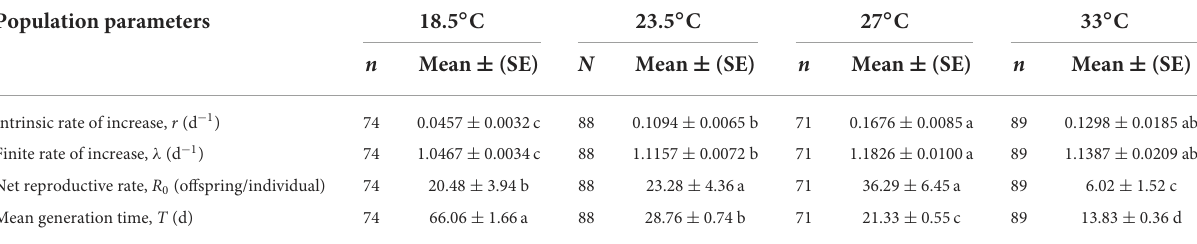
TABLE 3 Population parameters of Orius strigicollis preying on Frankliniella occidentalis at different temperatures. Population